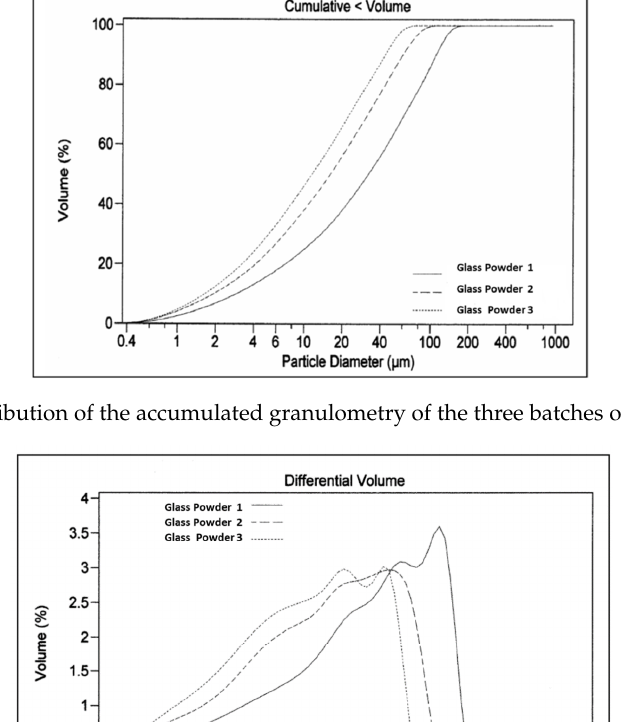
Figure 4. Differential particle size distribution of the three batches of glass powder. Figure 4. Di ff erential particle size distribution of the three batches of glass powder.